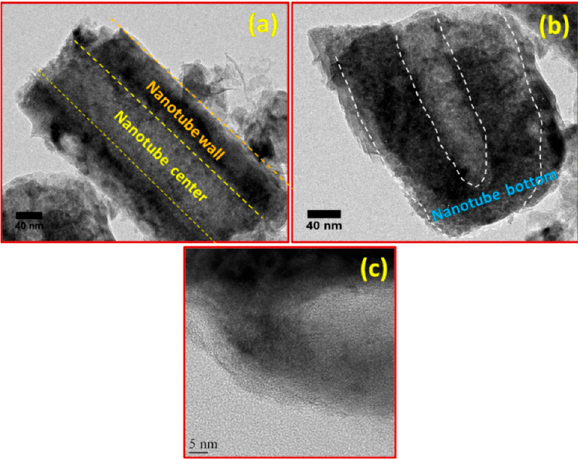
Figure 2. ( a ) Low and ( b ) high magnification field emission scanning electron microscopy (FE-SEM) images of TiO 2 nanotube arrays. ( c ) Corresponding energy-dispersive X-ray spectroscopy (EDX) spectrum.